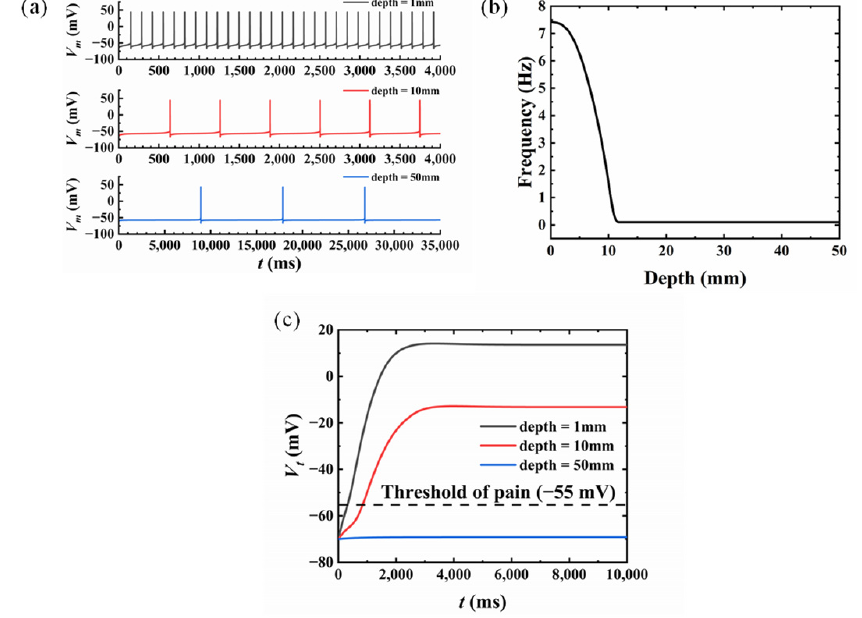
Figure 7. Skin pain sensation with different nociceptor locations: ( a ) membrane potential variation;